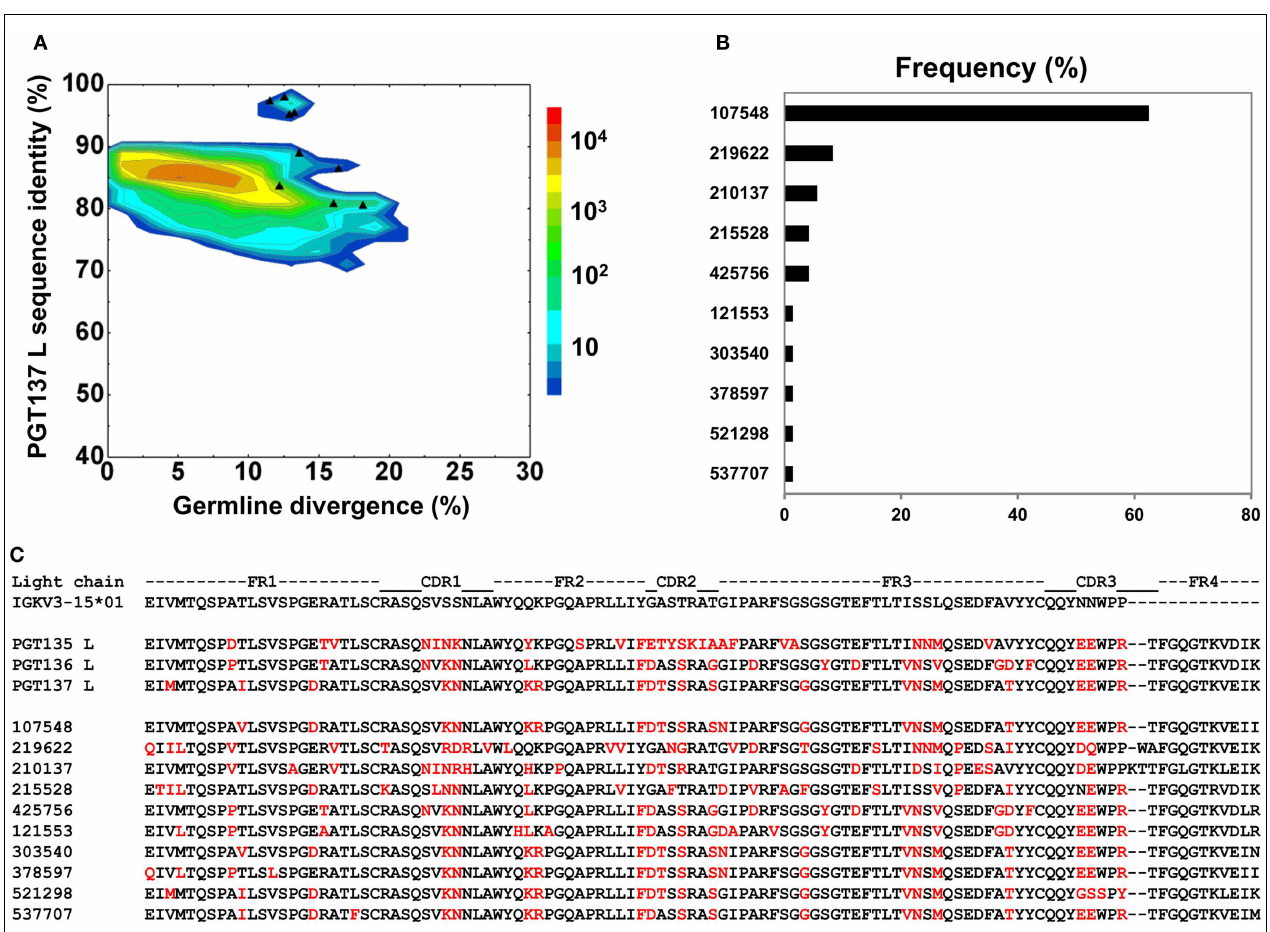
population of 10 clusters obtained using a sequence identity cutoff of 95%. Each cluster is indicated by its representative sequence. (C) Protein sequences of 10 cluster representatives. Sequences are aligned to the inferred germline gene, IGKV3-15 ∗ 01. Framework regions (FR) and complementarity-determining regions (CDRs) are based on Kabat nomenclature. Amino acids mutated from the germline gene are shown in